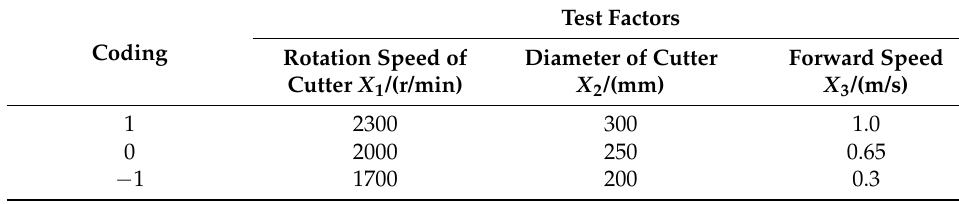
Table 3. Coding of test factors.